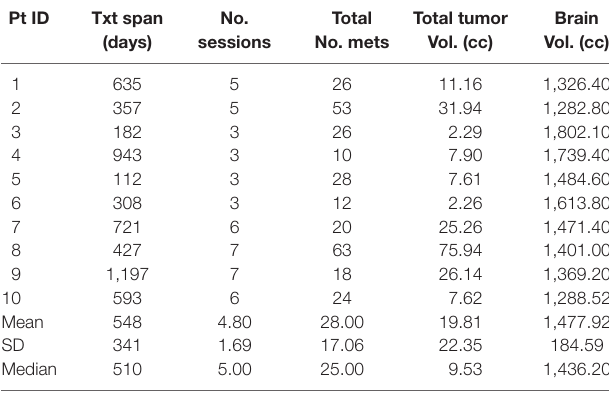
TaBle 2 | GKSRS treatment characteristics.